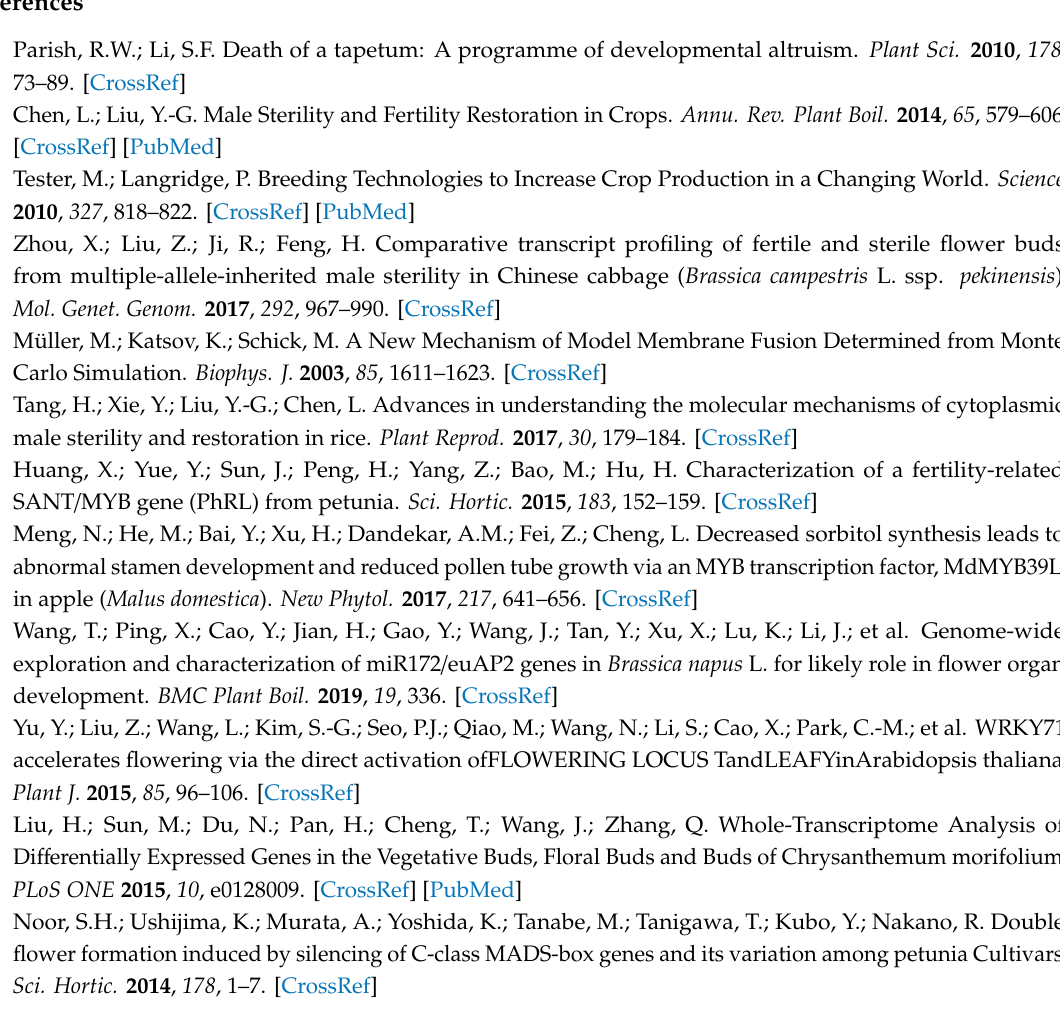
Figure S1: Morphological characteristics of flowers at di ff erent developmental stages. Figure S2: GO function annotation of unigenes. Figure S3: KOG function annotation of unigenes. Figure S4: KEGG function annotation of unigenes. Table S1: Statistical results of success rate of gene annotation were obtained from seven databases. Table S2: The comprehensive list of genes with all the annotations from the relevant databases. Table S3: The complist of detailed information for screening of di ff erentially expressed genes of in the three samples. Author Contributions: Conceptualization, M.L. and H.T.; Data curation, S.T., Y.L. (Ya Luo), Y.Z. (Yong Zhang), and Y.W.; Formal analysis, G.T. and Y.Z. (Yunting Zhang); Funding acquisition, M.L. and H.T.; Investigation, Y.L. (Yuanxiu Lin), Q.C., and F.Z.; Writing—original draft, M.L. and S.T.; Writing—review and editing, B.S. and